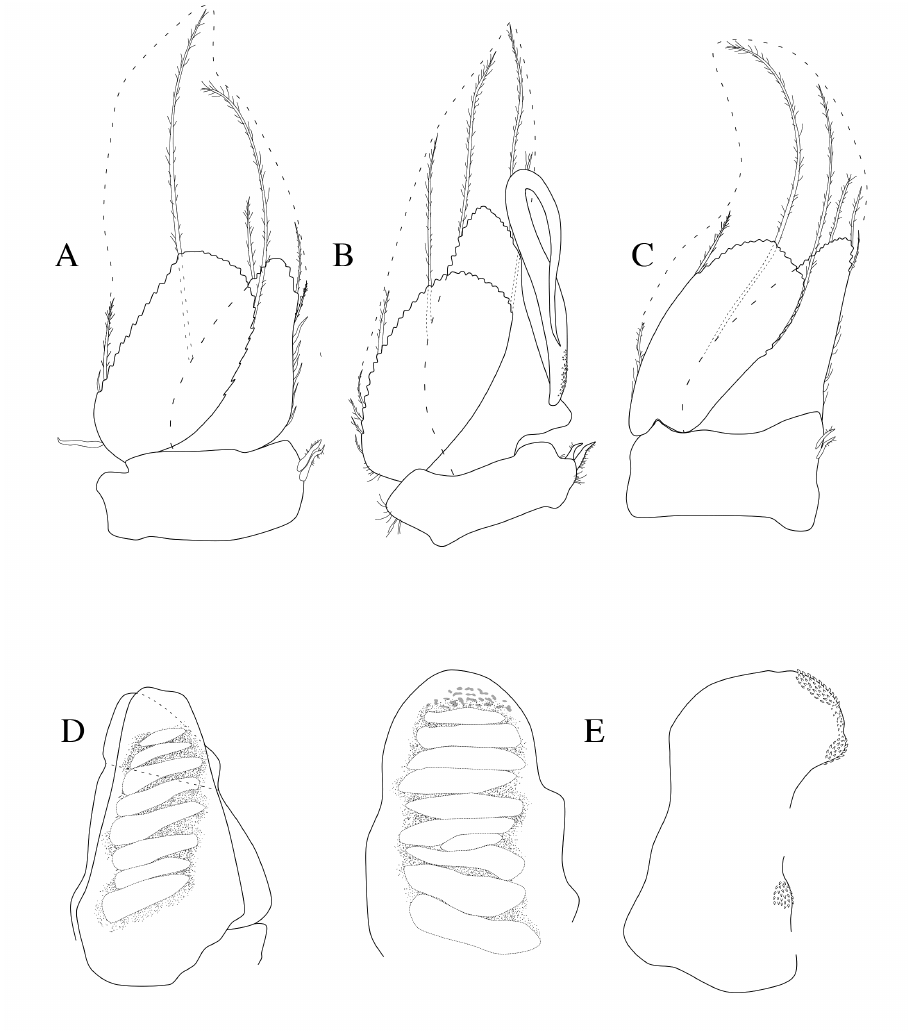
Figure 4. Dynoides elegans. ♂ Paratype. USNM 1422085. All appendages from left. A pleopod 1 B pleopod 2 C pleopod 3 D pleopod 4 E pleopod 5 (endopod and exopod separated).